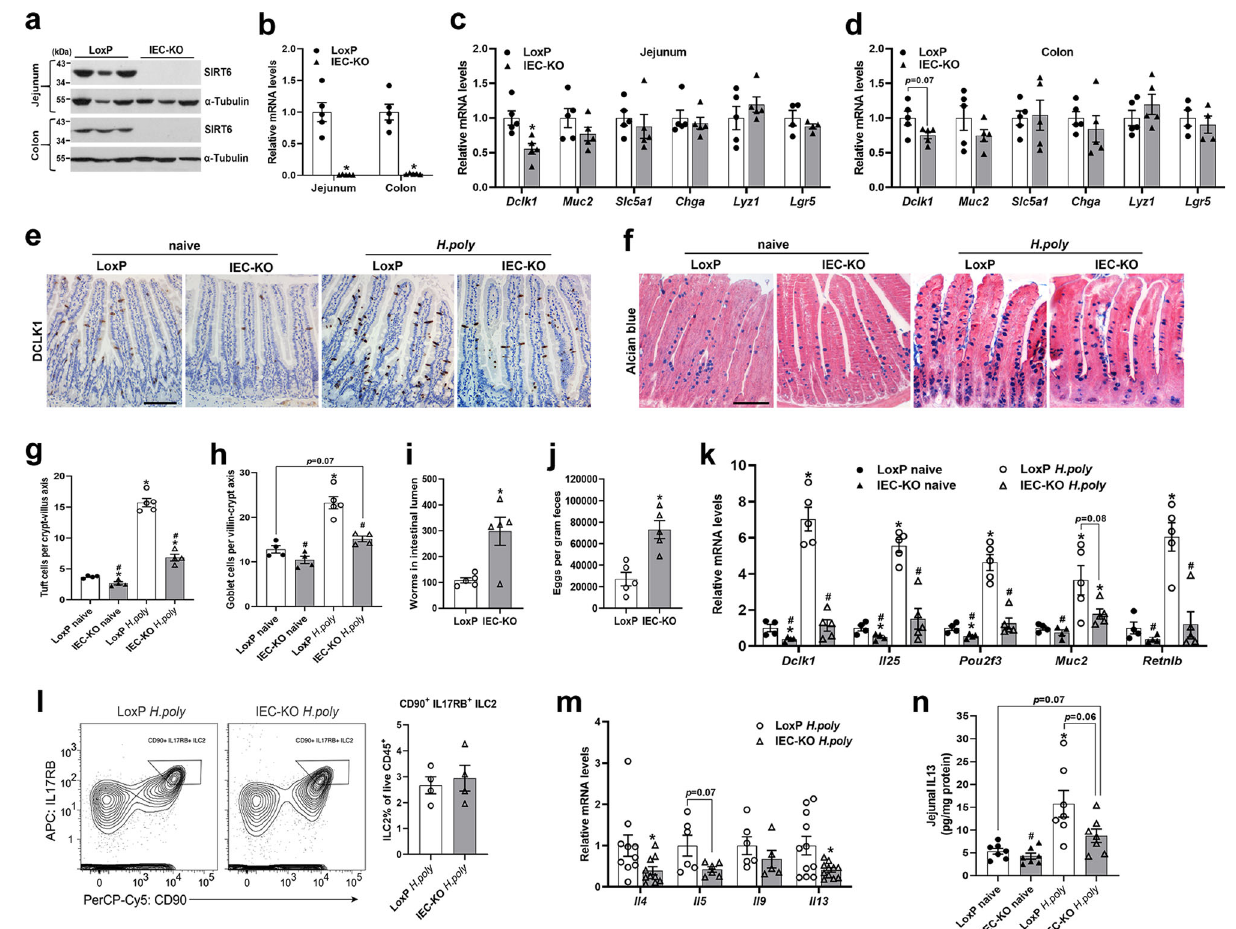
Fig. 1 | IEC-speci fi c deletion of Sirt6 results in defective tuft cell expansion and intestinal type 2 immune responses. 2 – 3-month-old male naive and/or H. poly - infected LoxP and IEC-KO mice were subjected to the following assays on day 14 post-infection. a , b Western blot ( a ) and qPCR ( b ) analyses of SIRT6 in the jejunal and colonic IECs of naive mice. n =5 mice/group in ( b ); p =0.0028 (jejunum) and 0.0014(colon). c , d qPCRanalysisoftheexpressionofIECmarkersinthejejunal( c ) andcolonic( d )IECsofnaivemice. Dclk1 , Muc2 , Slc5a1 , Chga , Lyz1 , n =5mice/group; Lgr5 , n =4 mice/group; p =0.0096 ( Dclk1 ) in ( c ). e Jejunal tuft cells were examined by immunostaining with anti-DCLK1 antibody (200X). f Jejunal goblet cells were examined by Alcian blue staining (200X). g Quanti fi cation of tuft (DCLK1 positive) cells shown in ( e ). n =4, 4, 5, 4 mice/group, respectively; 15 crypt-villus units counted for each mouse; from left to right, * p =0.0188, <0.0001, 0.0093; # p <0.0001 for both. h Quanti fi cation of goblet (Alcian blue positive) cells shown in ( f ). n =4, 4, 5, 4 mice/group, respectively; 15 crypt-villus units counted for each mouse; from left to right, * p =0.0005; # p =0.0001, 0.0021. i , j Analysis of parasite